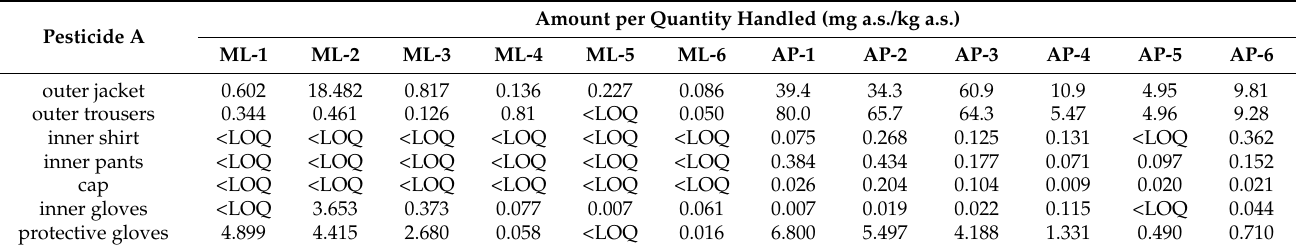
* ML1, ML2, ML3 and AP1, AP2, AP3 handled pesticide A (morning) while ML4, ML5, ML6 and AP4, AP5, AP6 handled pesticide B (afternoon) on the same crop, and thus have been exposed to pesticide A existing deposits. Table 5. Exposure results for pesticide B in mg a.s./kg a.s. handled for mixer/loaders and applicators *. Amount per Quantity Handled (mg/kg a.s.) Pesticide B